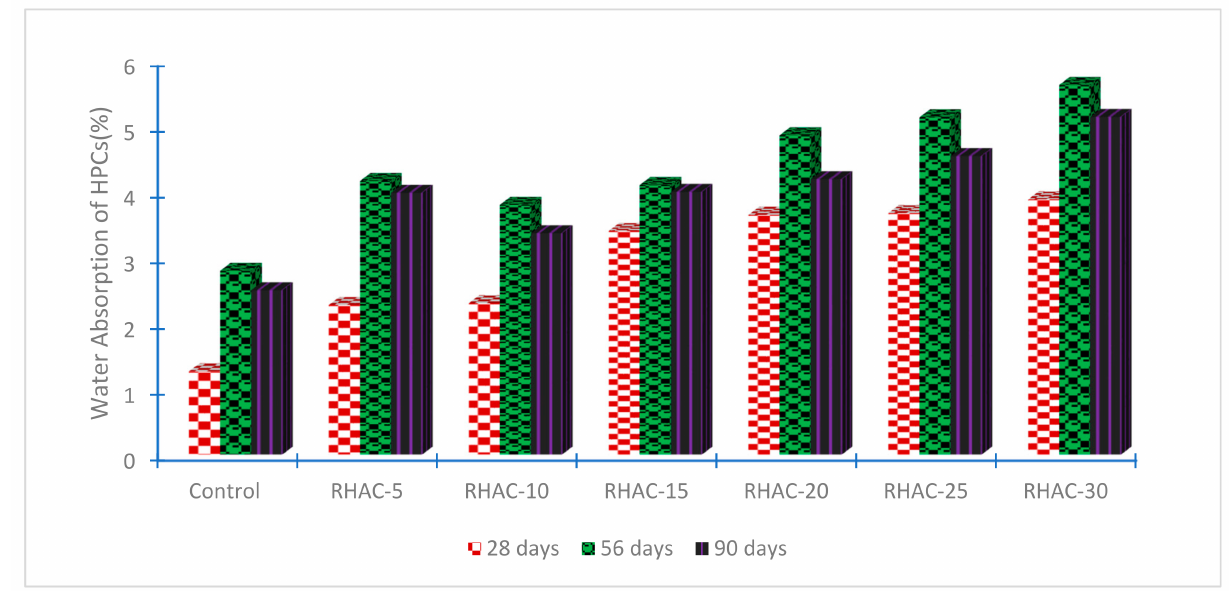
Figure 10. Water absorption development of HPCs incorporating RHA at different curing days.